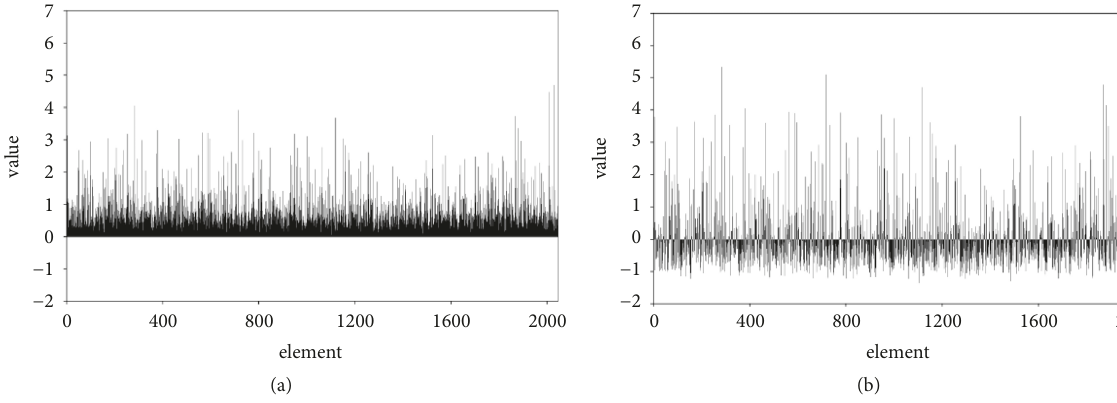
Figure 2: Visualization of scene category feature vector: (a) a raw vector, (b) a new vector normalized by Z-Score.